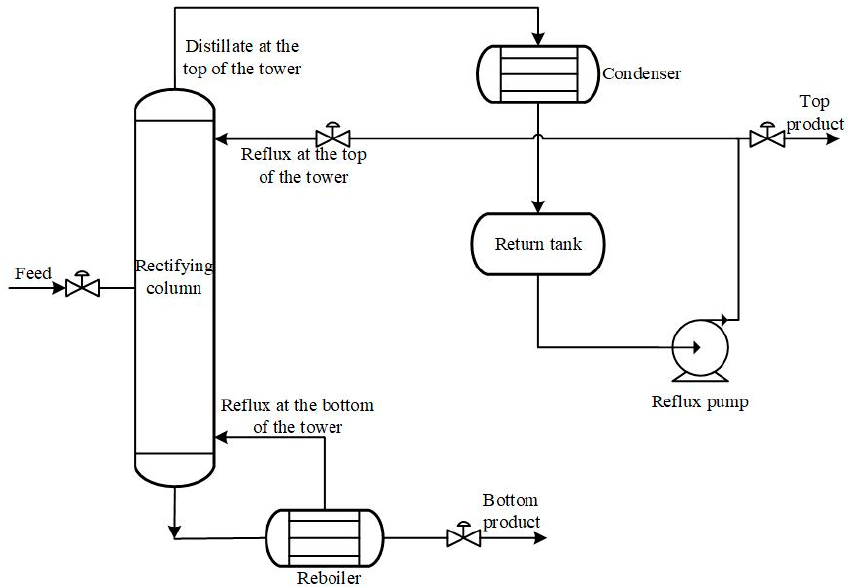
Figure 1. Structure of the distillation column.